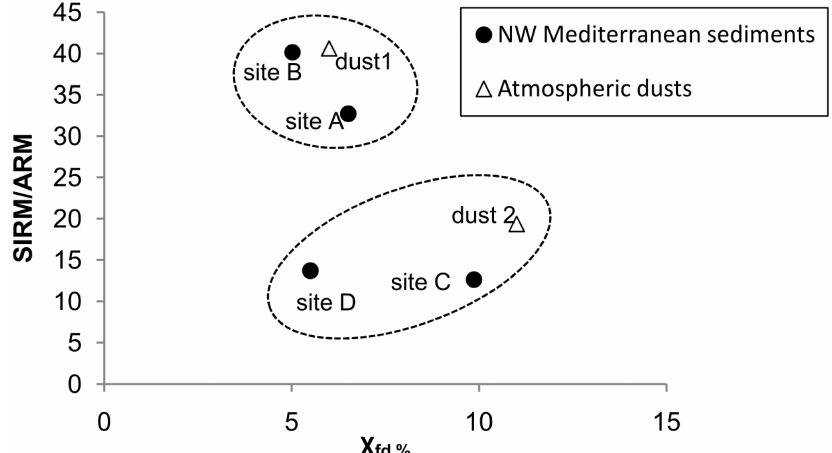
for atmospheric dust samples collected over Corsica and Figure 8. SIRM/ARM versus χ fd% surface sediments from the deep (>2000 m) NW Mediterranean Sea. Average values for the top centimeters of sediments corresponding to 100 years timespan (0–3 cm for sites A and B; 0–1 cm for sites C and